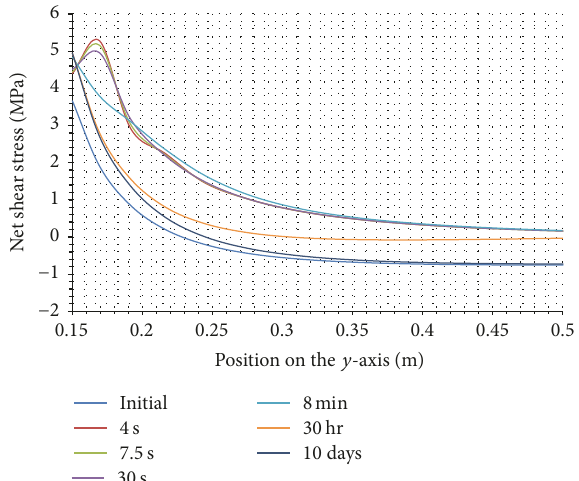
Figure 17: 𝑌 -component of maximum horizontal stresses as a function of time in poroelastic medium with 𝜎 𝐻 = 16.8 MPa and 𝜎 ℎ = 14MPa, 𝑃 𝑟 = 11MPa, 𝑃 𝑤 = 9.7 MPa, 𝑘 𝑥 = 0.01md, 𝑘 𝑦 = 0.01 md, and 𝑇 𝑚 = 300 K.